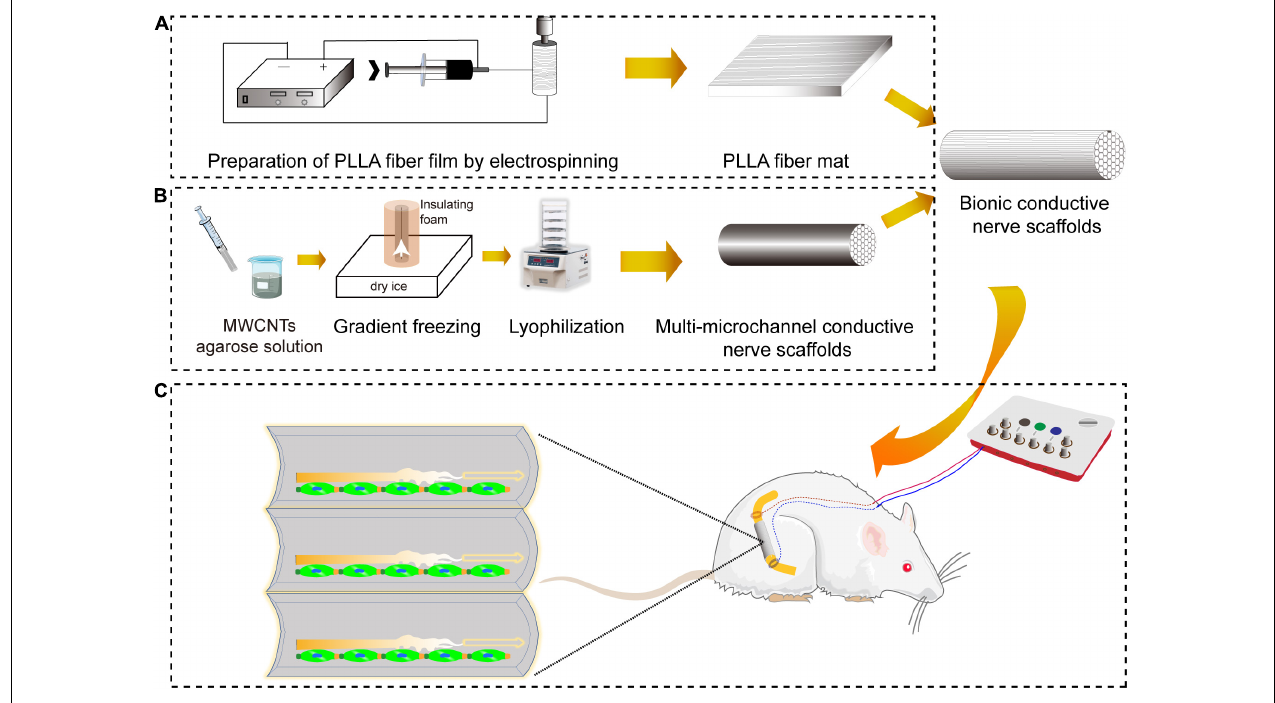
FIGURE 1 | The schematic diagram of repair of sciatic nerve defects by bionic conductive nerve scaffold in rats. (A) The preparation of PLLA fiber mats by electrostatic spinning. (B) The preparation of customized conductive nerve scaffolds with multi-microchannels. (C) Nerve regeneration promoted by bionic conductive nerve scaffold combining ES in vivo . PLLA, poly ( L -lactic acid); ES, electrical